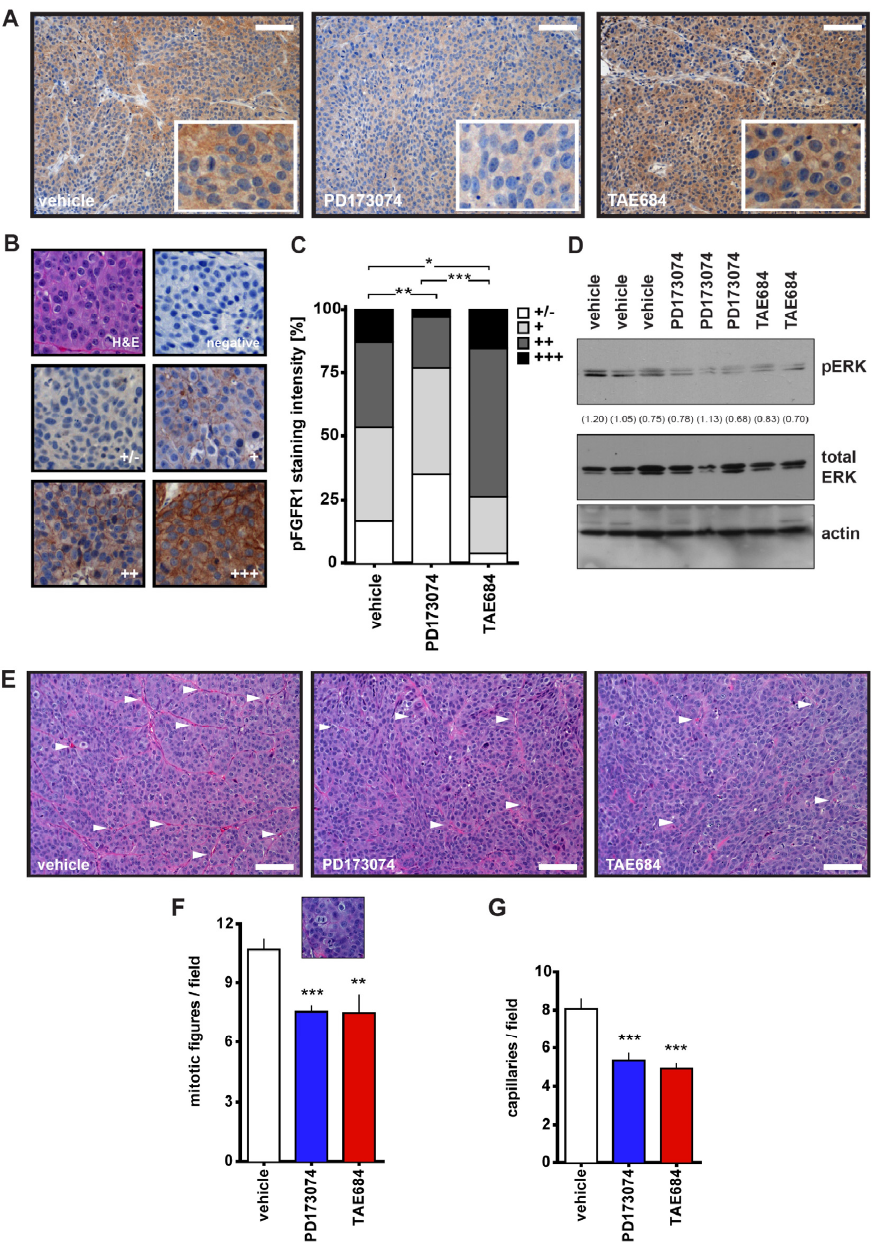
Figure 2. Effect of PD173074 and TAE684 7-day treatment on COLO357PL xenografts. ( A ): phospho- FGFR1 (pFGFR1) staining in representative tumor sections from different treatment groups (vehicle, PD173074 and TAE684), with zoomed inserts showing the localization of the staining. Scale bar, 0.1 mm. ( B ): Representative images of the pFGFR1 staining scale from negative to (+++) staining. ( C ): pFGFR1 staining intensity of the three treatment groups. * p < 0.05; ** p < 0.01; *** p < 0.0001; chi-square test. ( D ): Western blot for phospho- and total ERK of protein lysates from frozen tumor samples. ( E ): Representative H&E-stained tumor sections of the three treatment groups. Scale bar, 0.1 mm. ( F , G ): Ten pictures of different fields per tumor sample were analyzed for mitotic figures ( F ) and the number of capillaries ( G ). Mean ± SEM, ** p < 0.01; *** p ≤ 0.0002; unpaired two-tailed t -test. White arrowheads in panel ( E ) indicate capillaries. The insert in panel ( F ) shows an example of a mitotic figure. All the whole western blot figures can be found in the supplementary